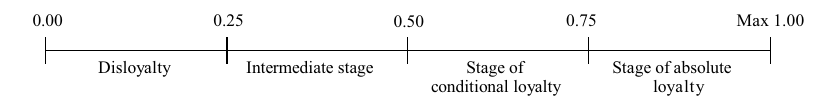
Disloyalty Intermediate Fig. 4. Scale of measuring customer loyalty towards a service provider